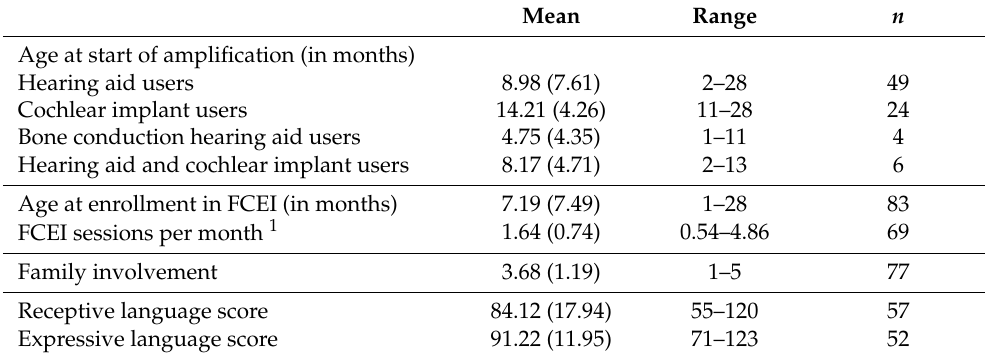
Table 3. Details on intervention-related factors (mean, SD, range and number of participants).